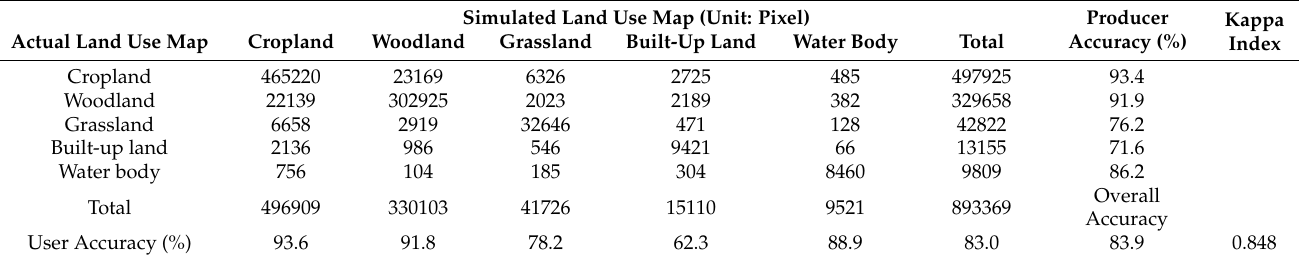
Table A1. Confusion matrix between simulated and actual land use map in